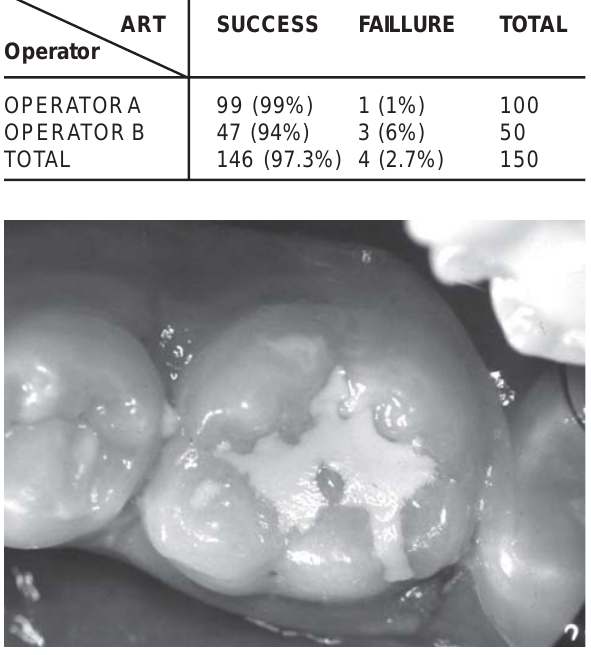
Figure 6- Restoration placed, at baseline